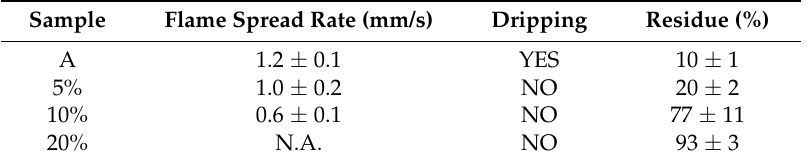
Table 1. Flammability data of untreated and treated acrylic fabrics from horizontal flame spread tests.